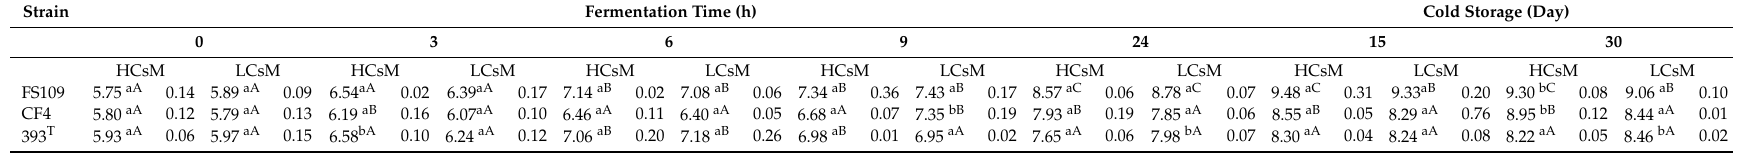
Table 5. Growth kinetic (log CFU / mL) of L. paracasei strains in HCsM and LCsM milk during fermentation and cold